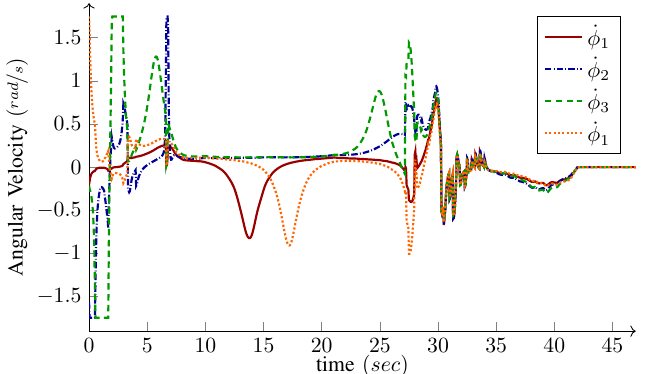
Figure 17. Experiment : Steering velocities ˙ φ i for the bounded velocity path-following of iMoro depicted in Figure 15. The maximum steering velocity for all the wheels ( ˙ φ (max) (110